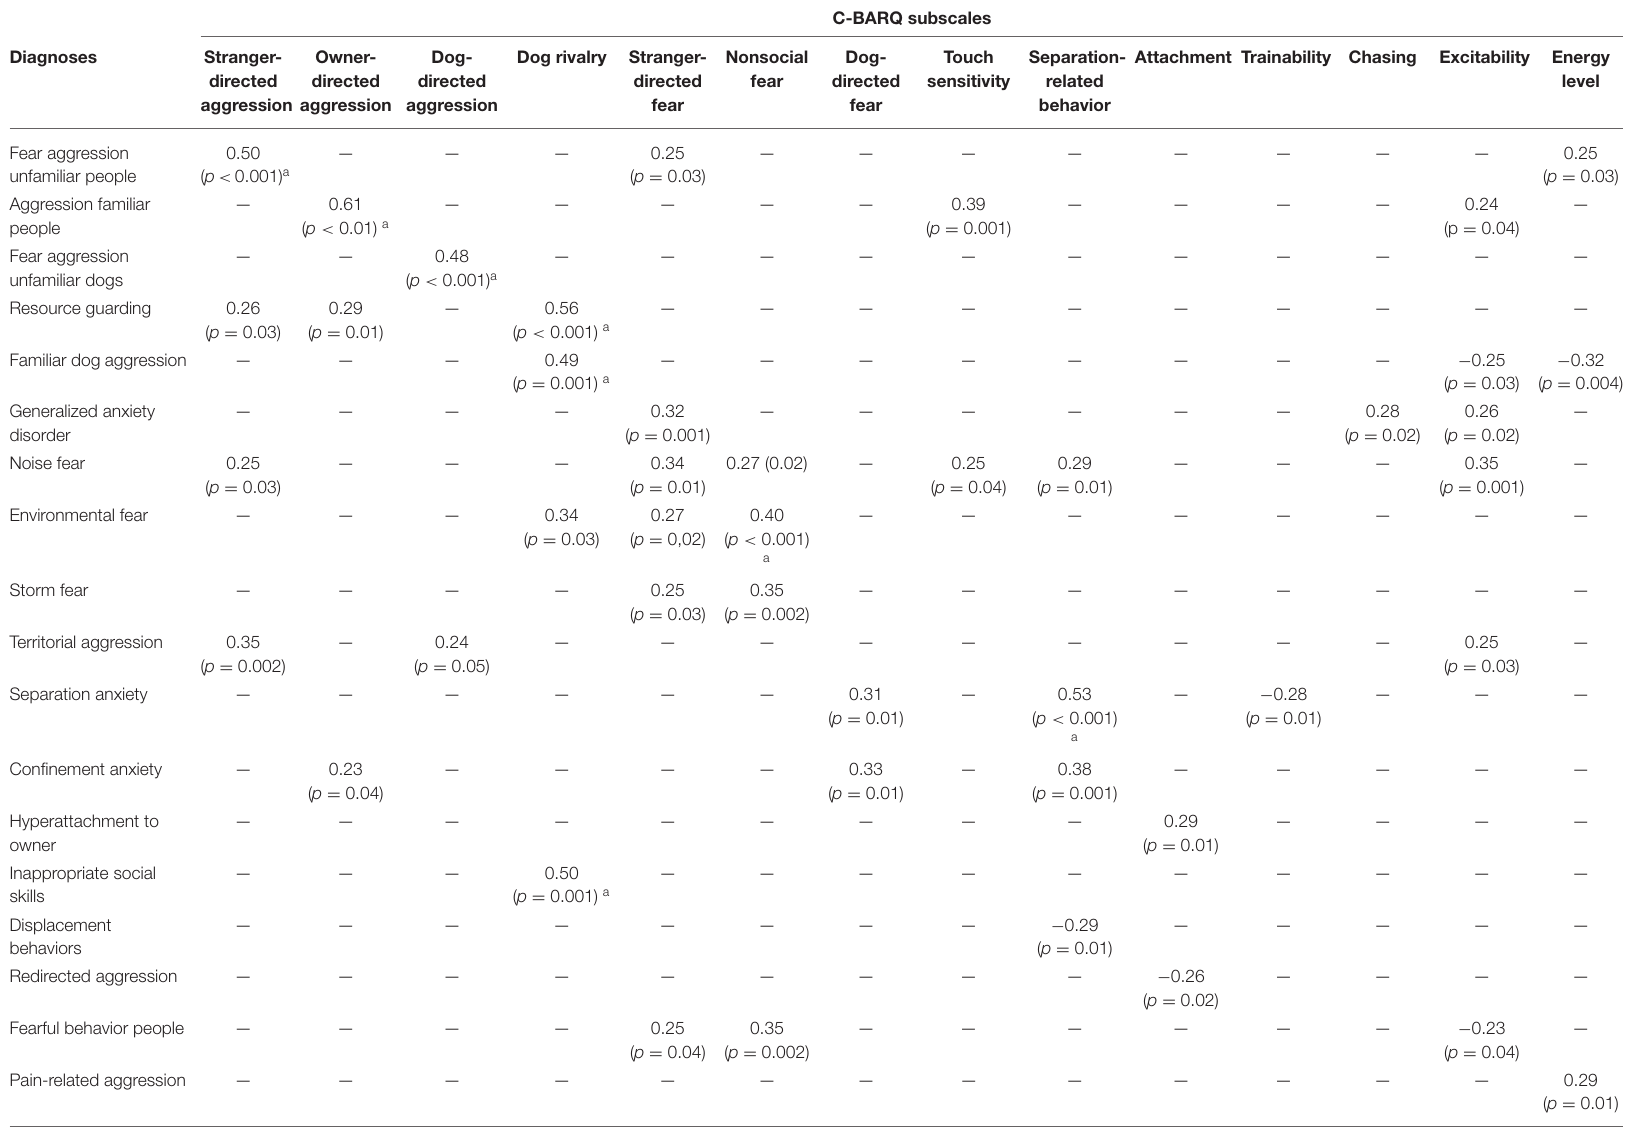
TABLE 2 | Spearman’s rank correlation coefficients ( r s ) between veterinarian behavioral diagnoses and C-BARQ subscale scores at baseline ( n = 131).